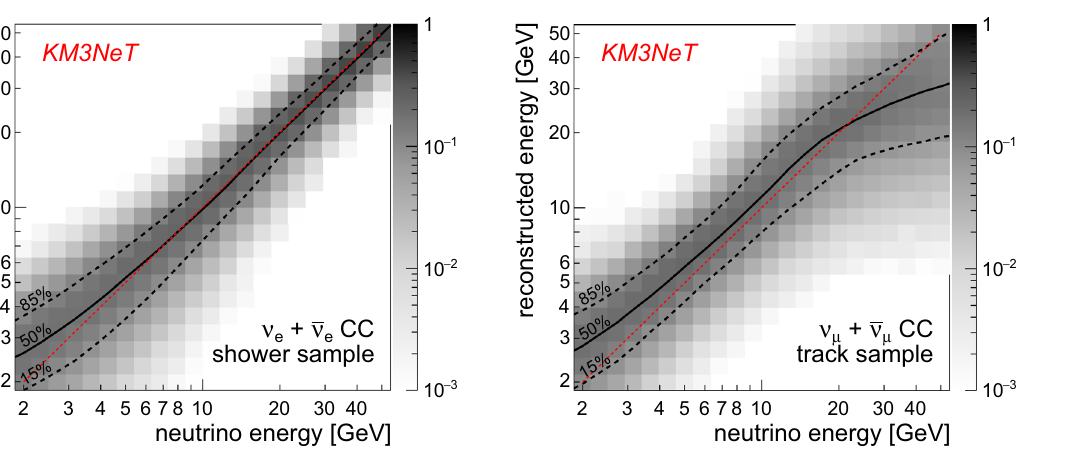
track-like (right). Solid and dashed black lines indicate 50, 15 and 85% quantiles. For a definition of shower- and track-like events see Eq. 2. The red diagonal line indicates perfect energy reconstruction